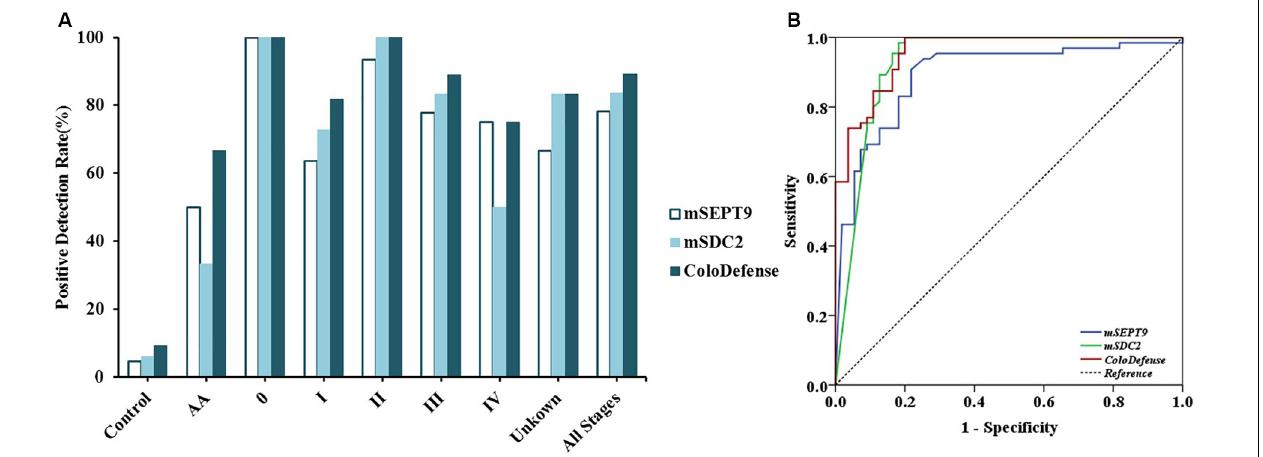
FIGURE 2 | Performance of ColoDefense test in detecting control, AA and CRC across stages 0–IV in the training set. (A) Positive detection rates for control and all stages of CRC. (B) ROC curves for ColoDefense test in detecting